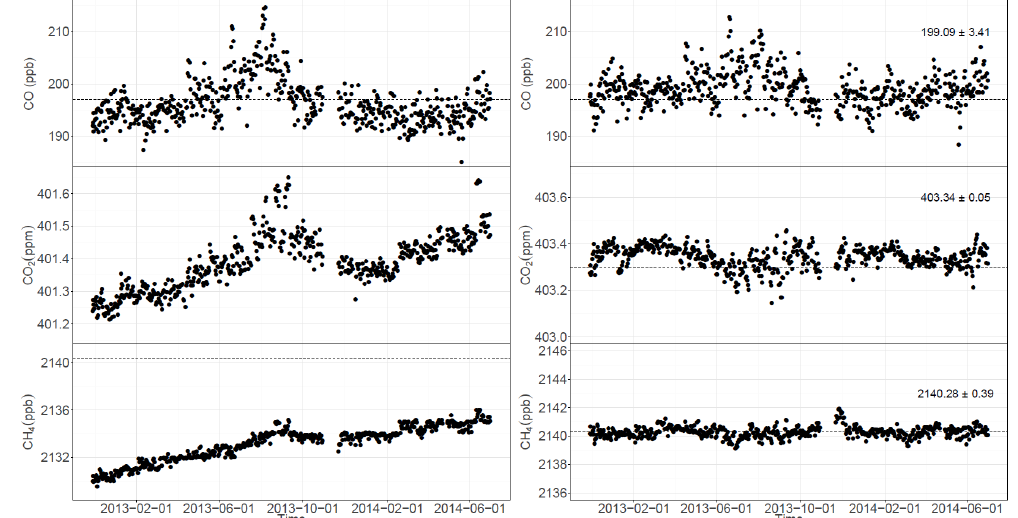
Figure 3. Time series of daily target gas measurements for CO, CO 2 , and CH 4 for raw instrument readings (left) and span-calibrated values (right). The horizontal dashed line represents the assigned target gas mixing ratios calibrated in the laboratory before deployment to the field. In the case of the raw CO 2 measurement, the assigned value (403.300ppm) is not shown as the offset is much bigger than the measurement scale shown in the